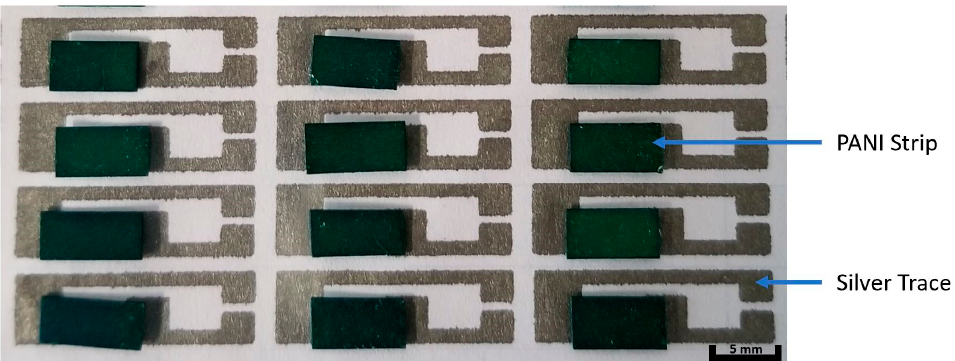
Figure 2. Photographic image of the paper sensor device after the initial silver traces were printed and before the secondary silver paste layer was formed to secure the strip to the device.